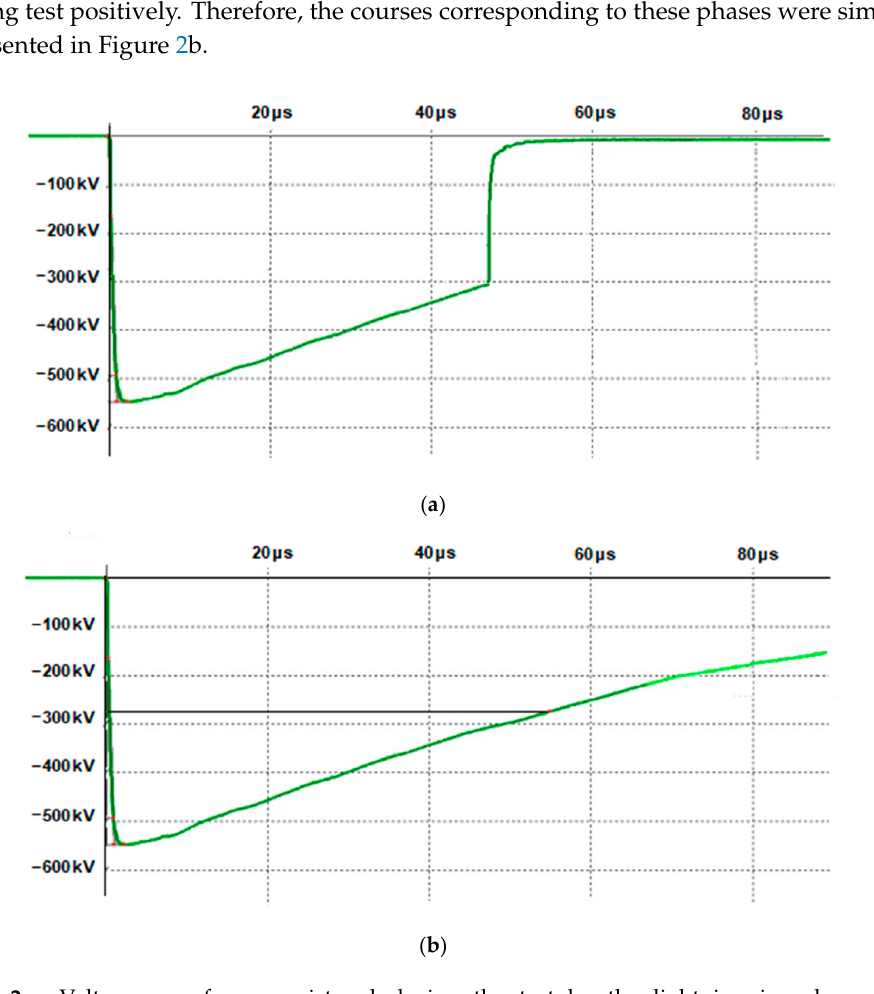
Figure 2. Voltage waveforms registered during the test by the lightning impulse voltage 1.2 µs ± 30%/50 µs ± 20% and peak value of 550 kV: ( a ) when the lightning impulse test was failed, ( b ) when the test was